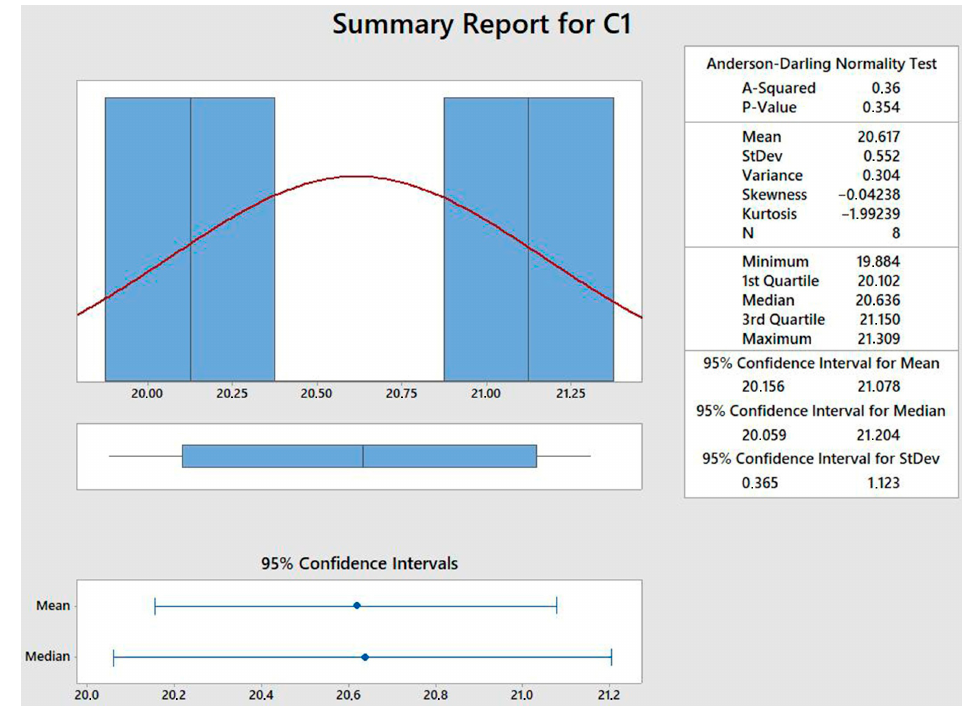
Figure 8. A 95% con fi dence interval . Figure 8. A 95% confidence